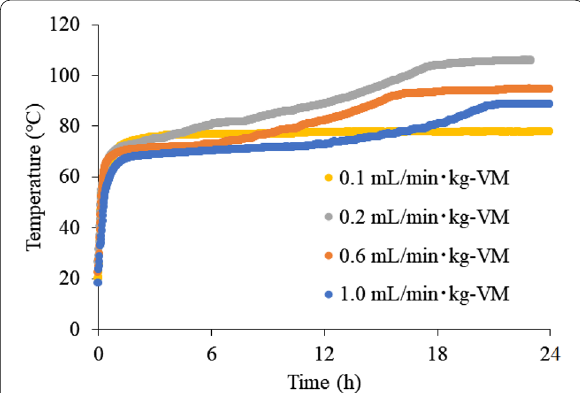
Fig. 5 Self-heating of cedar sawdust at each aeration rate